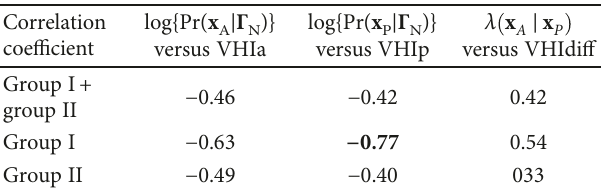
Table 8: Correlation coe ffi cients between voice quality estimates and VHI